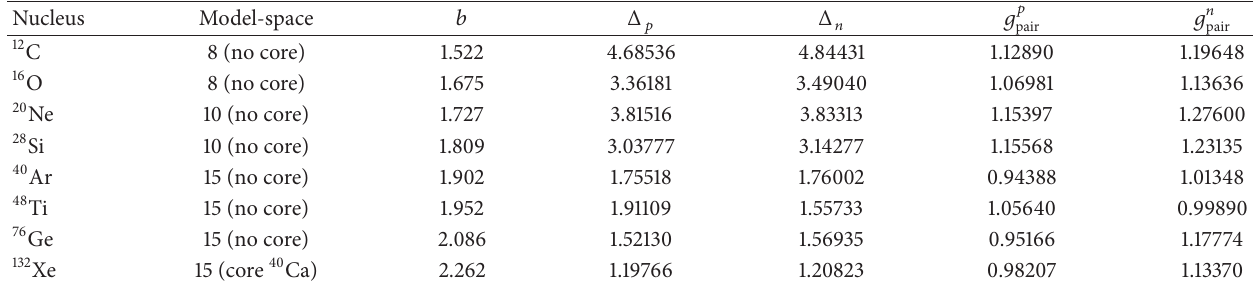
Table 1: The values of proton 𝑔 𝑝 and neutron 𝑔 𝑛 pairs that renormalise the residual interaction and reproduce the respective empirical pair pair pairing gaps Δ 𝑝 and Δ 𝑛 . The active model space and the harmonic oscillator parameter, for each isotope, are also presented.